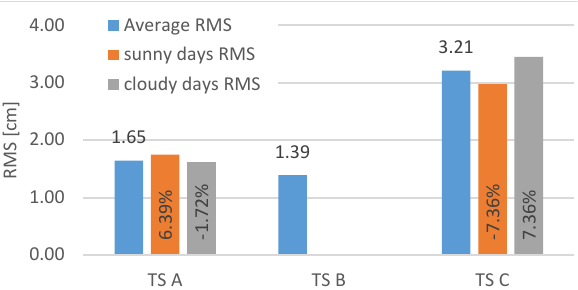
Figure 7. Average RMS obtained computing all the models and the RMS obtained analysing the sunny or cloudy days only.